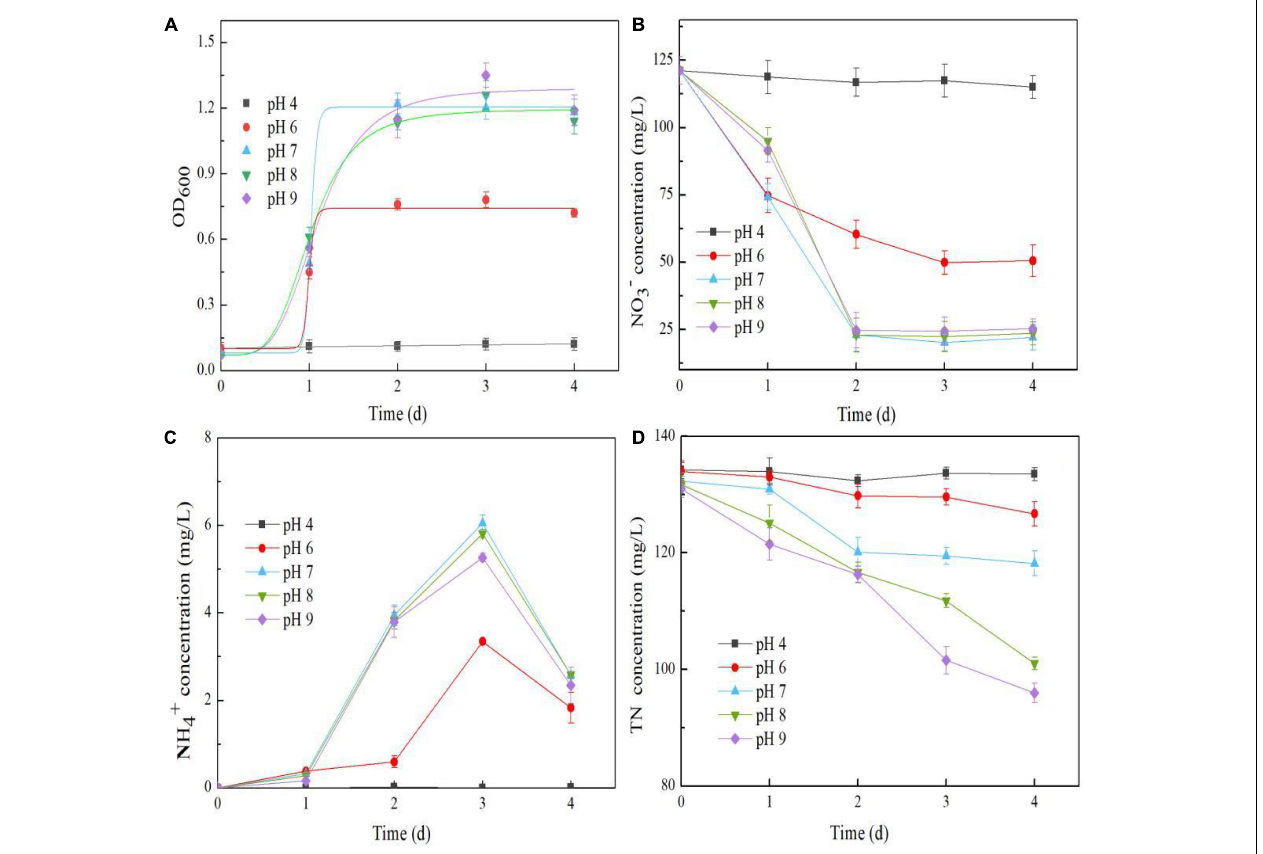
FIGURE 5 | Effects of pH on the OD 600 (A) , NO 3 − concentration (B) , NH 4 + concentration (C) , and TN concentration (D) in the Pseudomonas putida Y-9 culture with glucose as the carbon source.